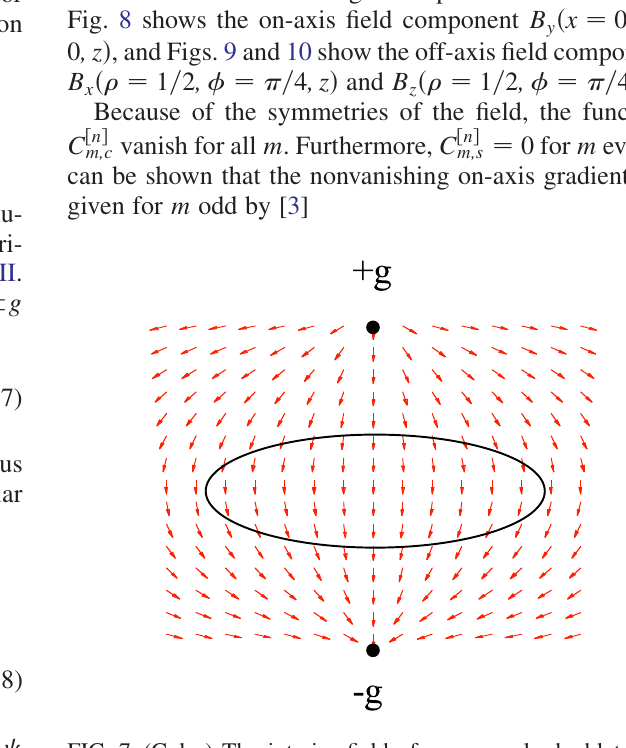
FIG. 7. (Color) The interior field of a monopole doublet. Also shown is an ellipse which will be used in Sec. IV